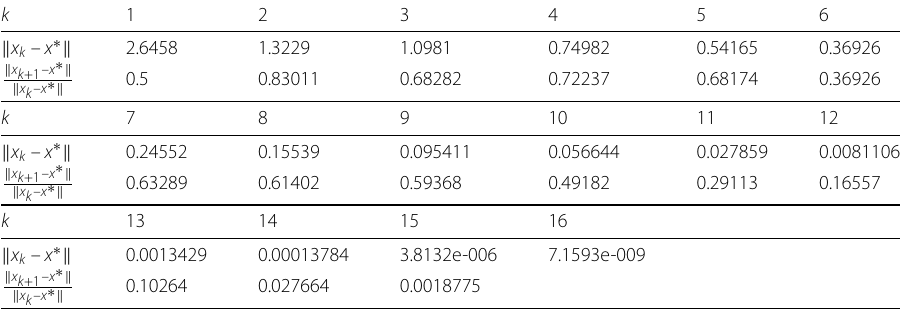
Table 4 Experimental results of Example